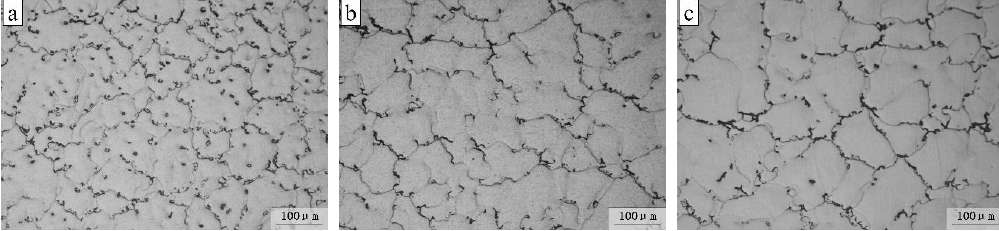
Figure 4. Microstructures of as-cast ZK60 alloy without ultrasonic processing at ( a ) center; ( b ) 1/2R; ( c ) edge position of billet.